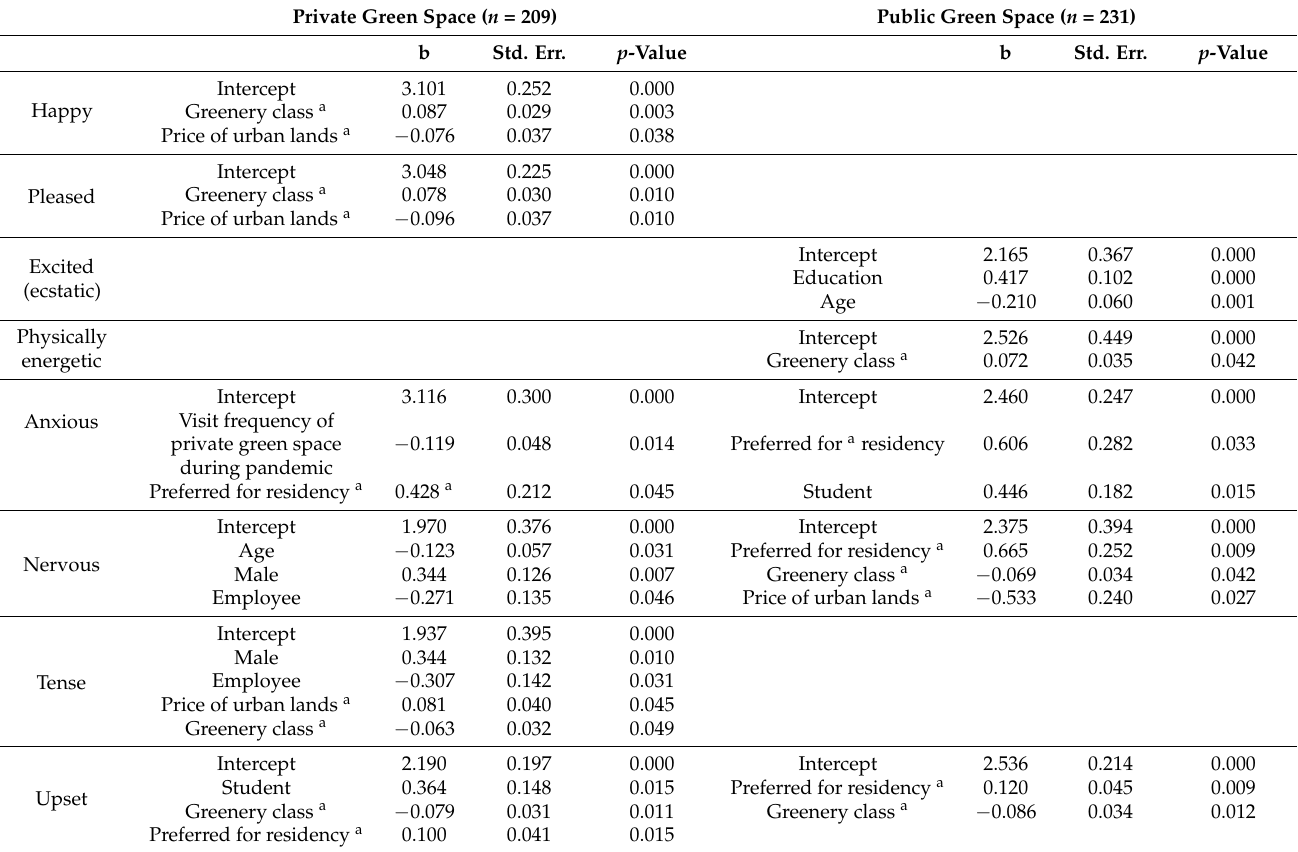
Table 3. Feelings in a private (left) or public (right) green space in relation to some independent variables. Private Green Space ( n = 209) Std. Err. Std.